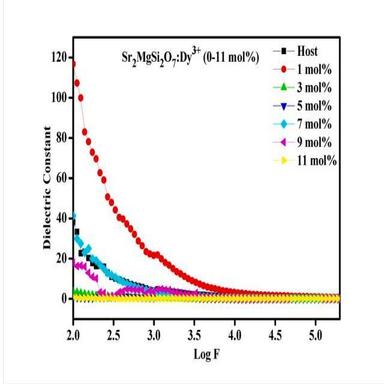
Dielectric constant versus Log F for Sr2MgSi2O7:Dy3þ NPs.